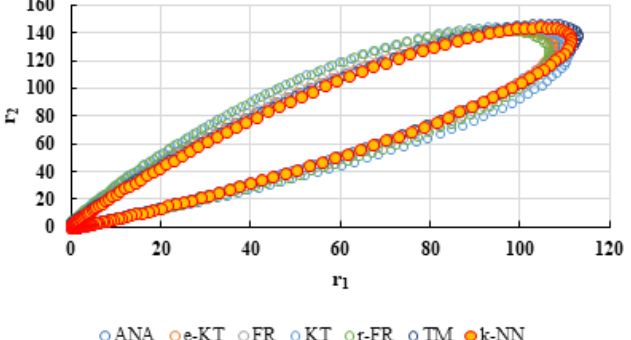
Figure 20. The JCR of analyzed methods for reactivity ratios calculation for copolymerization of NPEA-NVP [39].